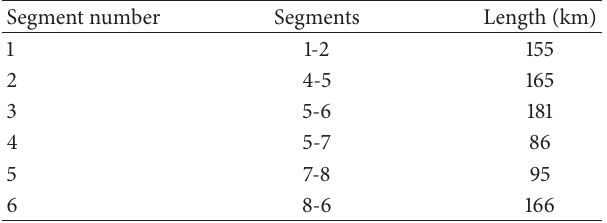
Table 2: Lengths of segments in the paths.